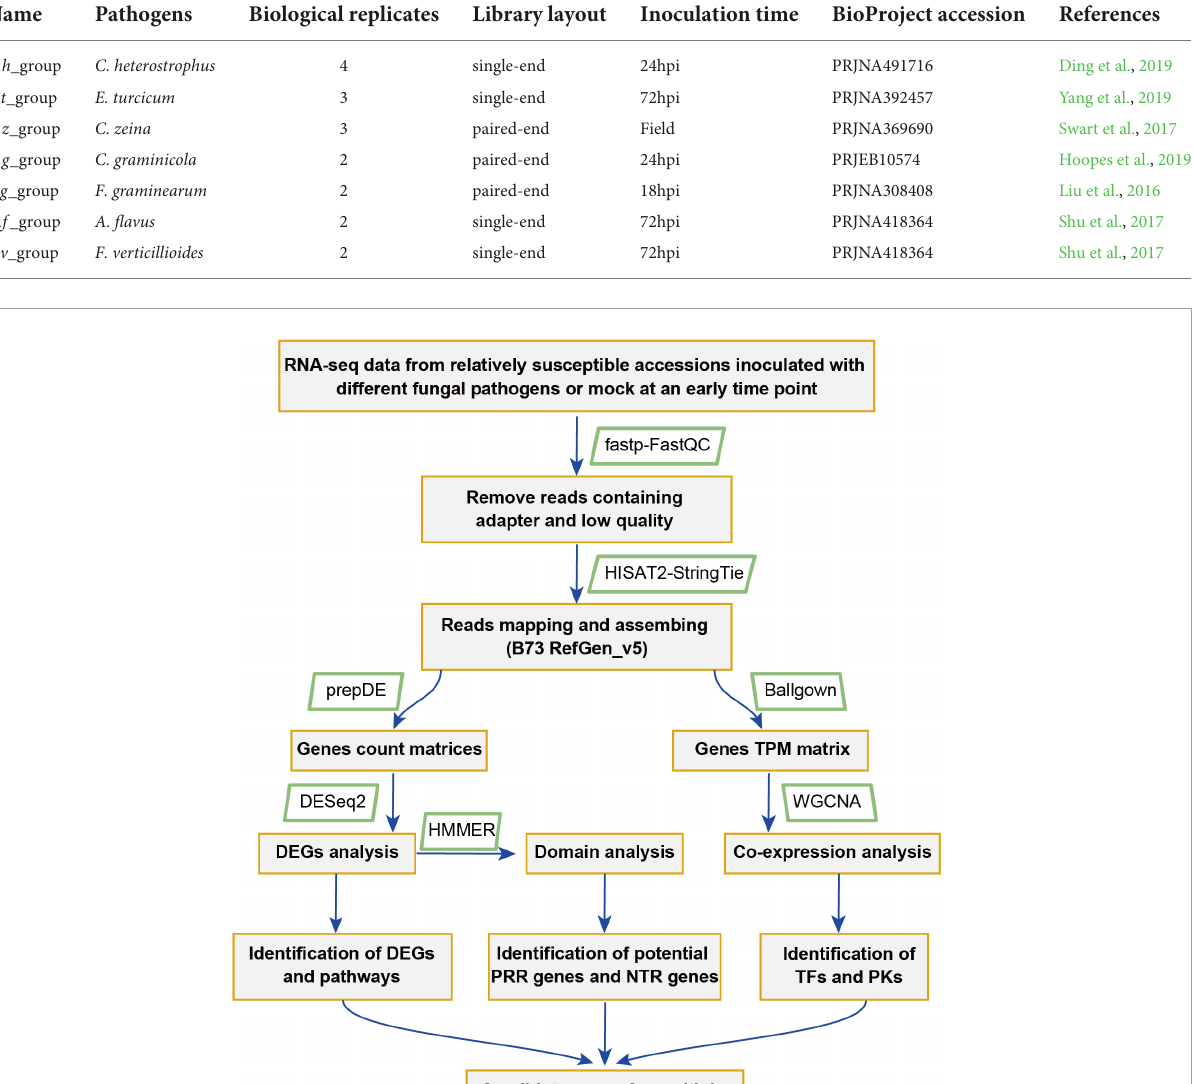
respond to C. heterostrophus very fast and 24 hpi is a relatively late time